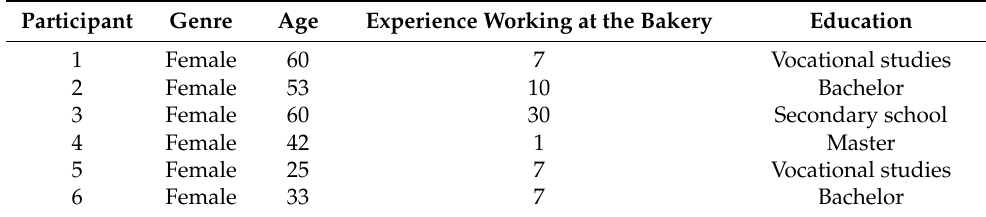
Table 1. Profile of the